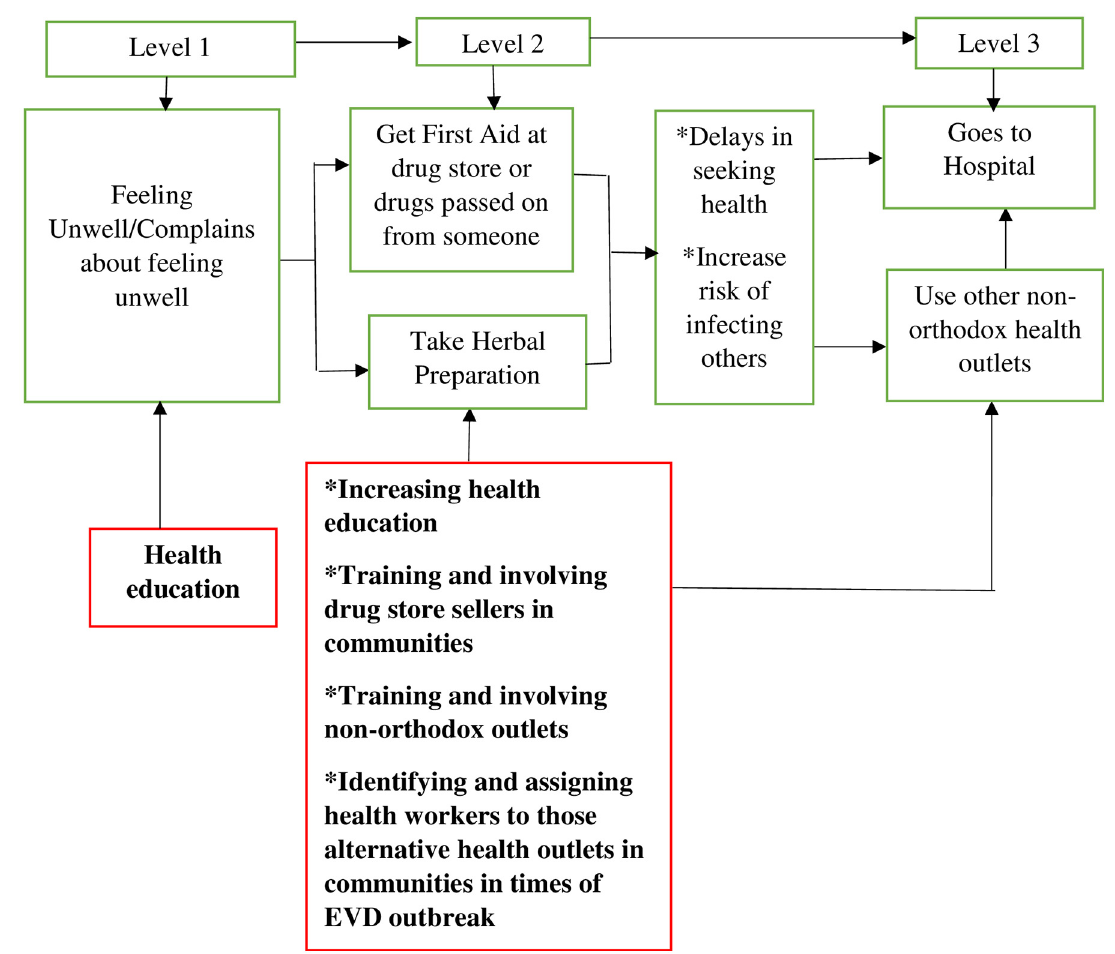
Fig 3. Diagrammatic representation of health seeking behaviour and strategies to contain EVD during an